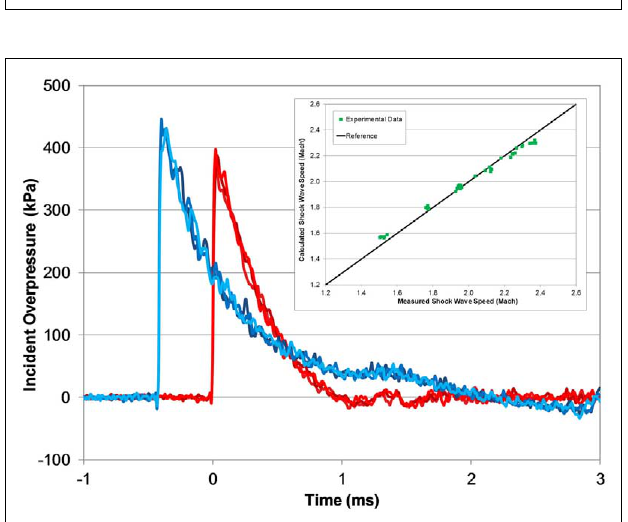
FIGURE 7 |Typical open-tube pressure time-histories measured with three PTs at the end of the tube (red) and 305mm upwind (blue; 1240mm helium-driven tube, 5000kPa burst). Measured shock wave speed matches theoretical speeds for a fully developed shock wave (inset).